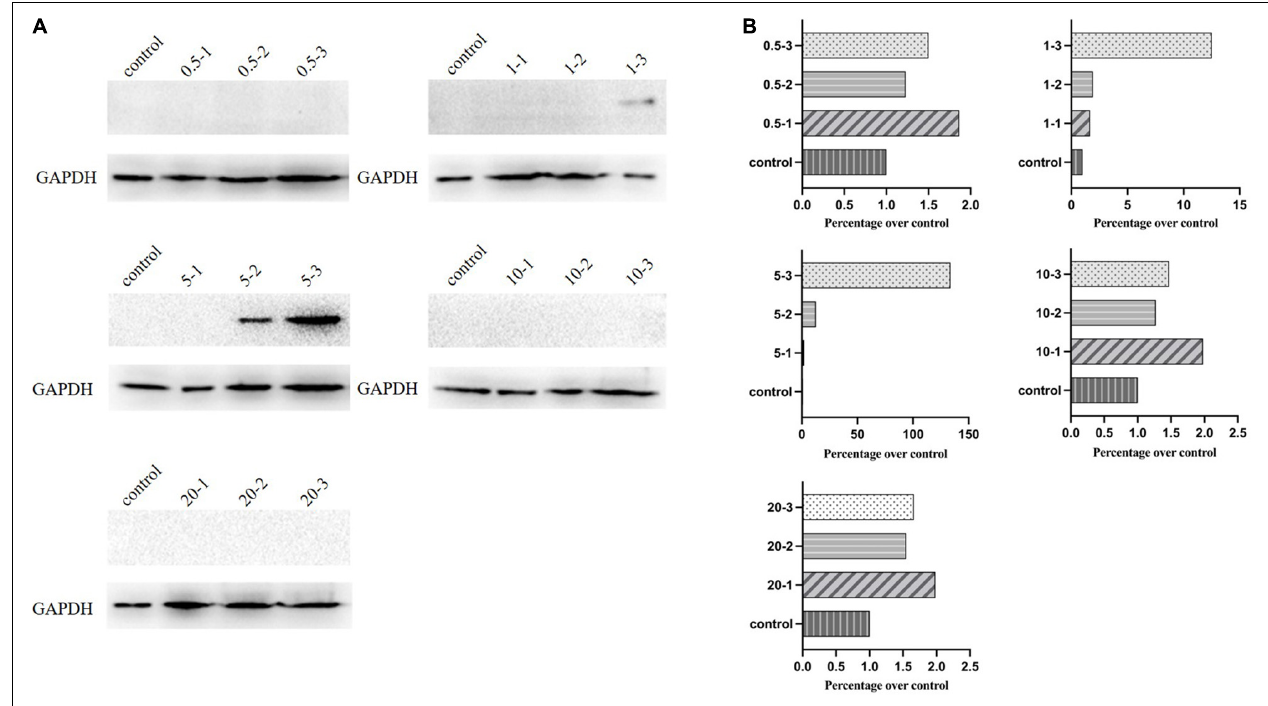
FIGURE 5 | Western blot analysis of G protein expression. (A) Protein expression levels of G for the initial infection by Western blotting. (B) ImageJ measured the expression levels.